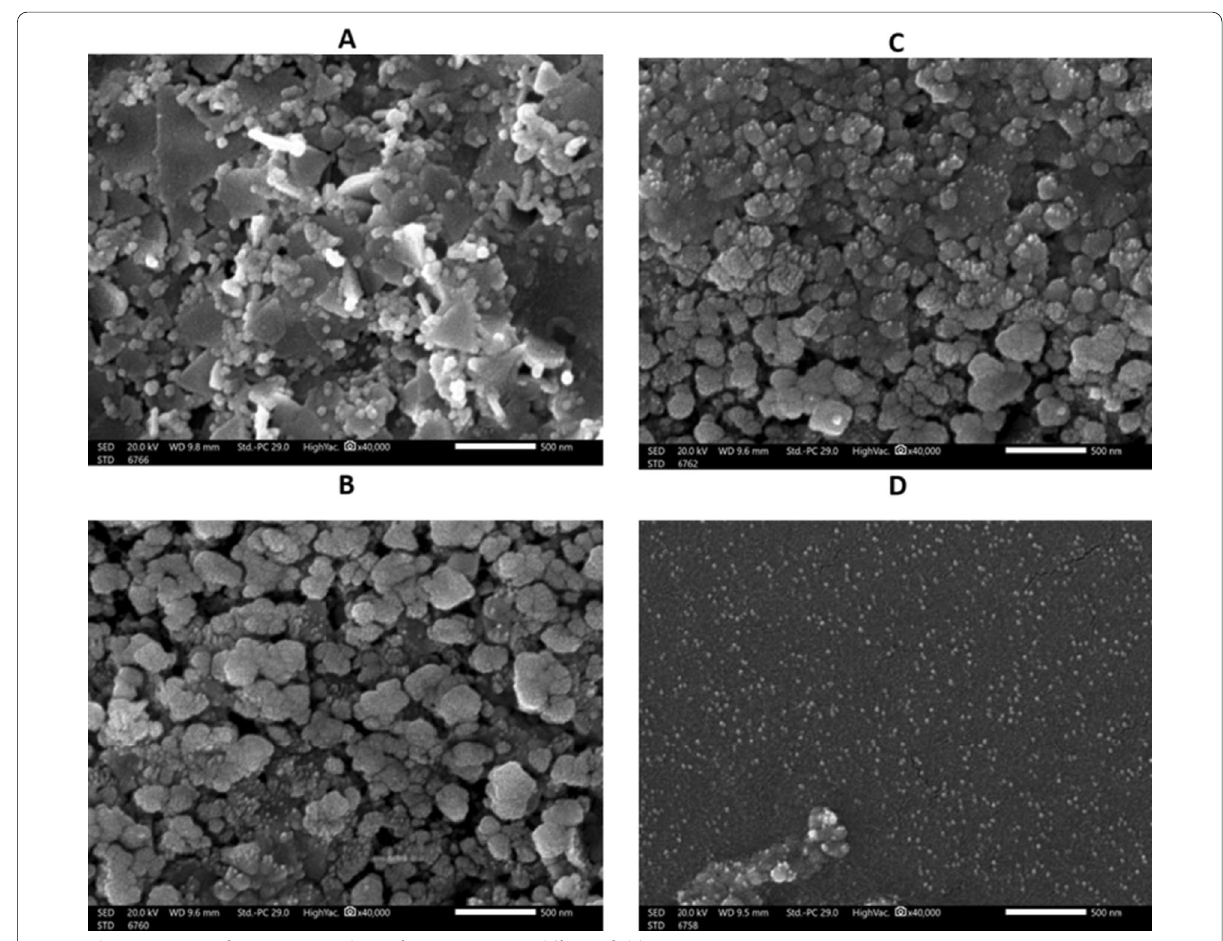
Fig. 5 The SEM images for A AuNPs and B – D for Au@AgNPs in different